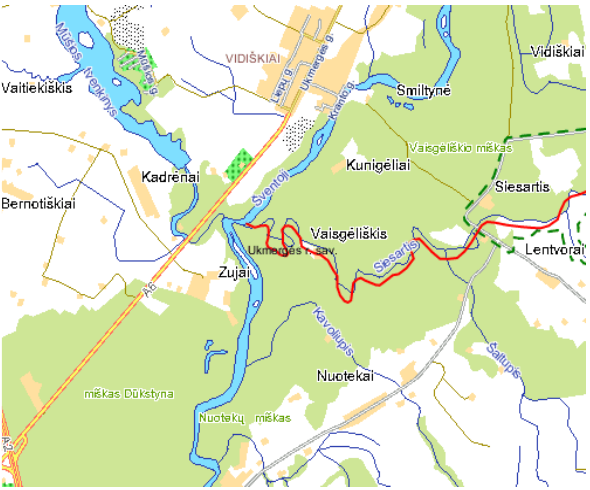
Fig. 3. Stone loach collecting sites in the lower reaches of the Siesartis River in Ukmerg ė district in 2007 5 to 7-year-old stone loach of approximately the same size (average weight of 10 g) and yearlings of rainbow trout (average weight of 10 g) were selected for experimental investigation.